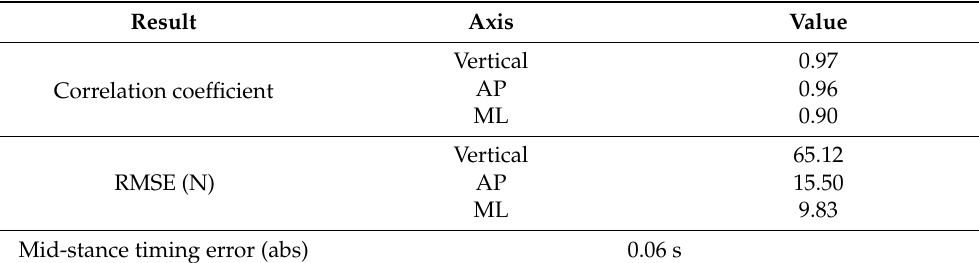
Table 2. The correlation coefficients and RMSEs between estimated and measured GRFs and the mid-stance timing error.